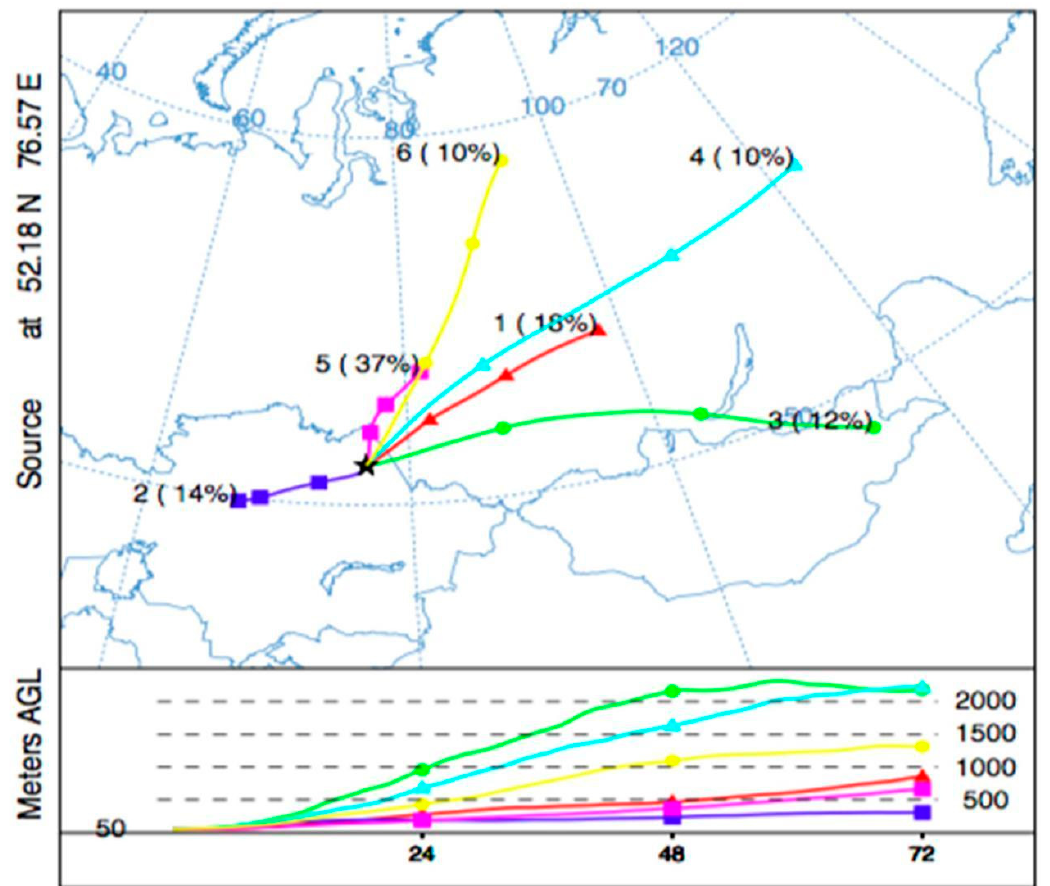
Figure 7. Optimum trajectory clusters (n = 6) for heating period. Non-Heating